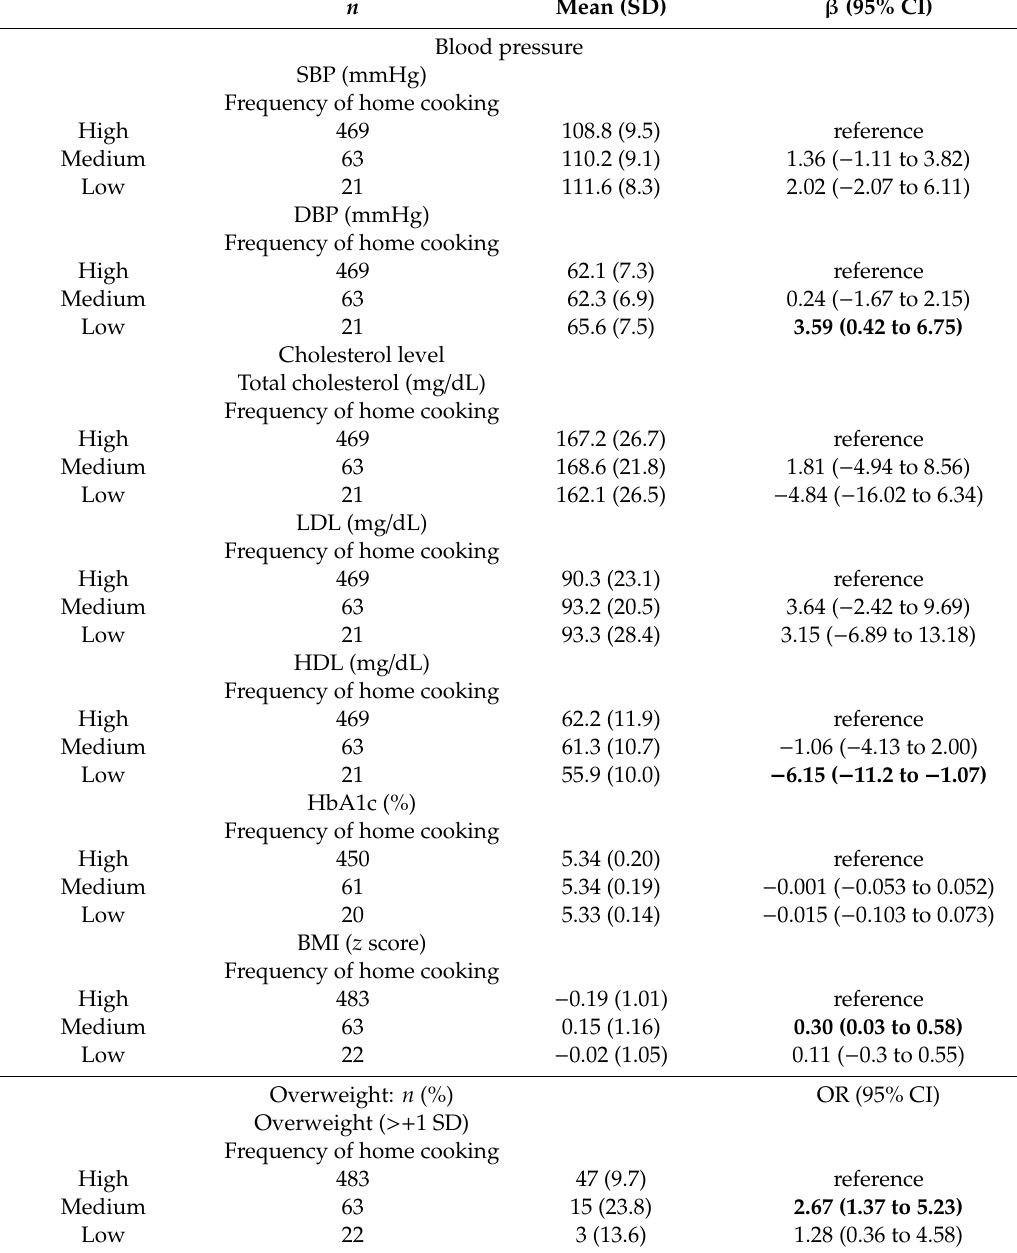
Table 2. Results of linear and logistic regression analyses of indicators of cardiometabolic factors for Japanese adolescents by frequency of home